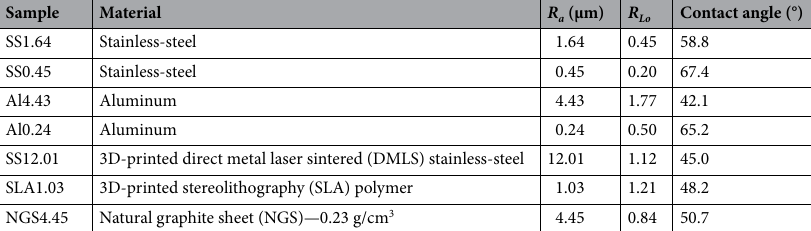
Table 1. A summary of surface roughness values for each sample, measured by the SJ-400 profilometer. Contact angles were measured using a sessile drop method.